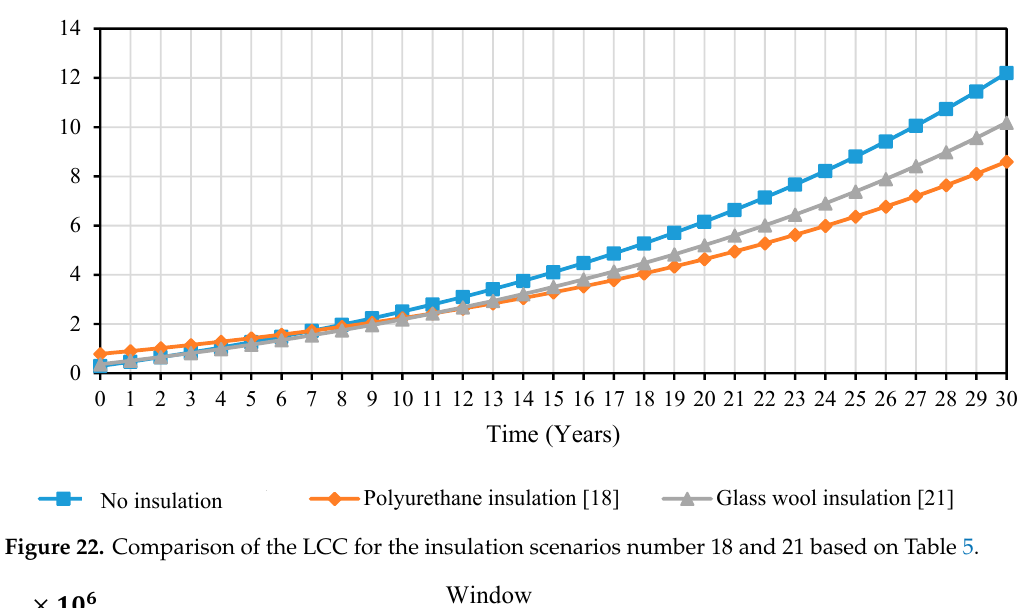
Figure 22. Comparison of the LCC for the insulation scenarios number 18 and 21 based on Table 5.